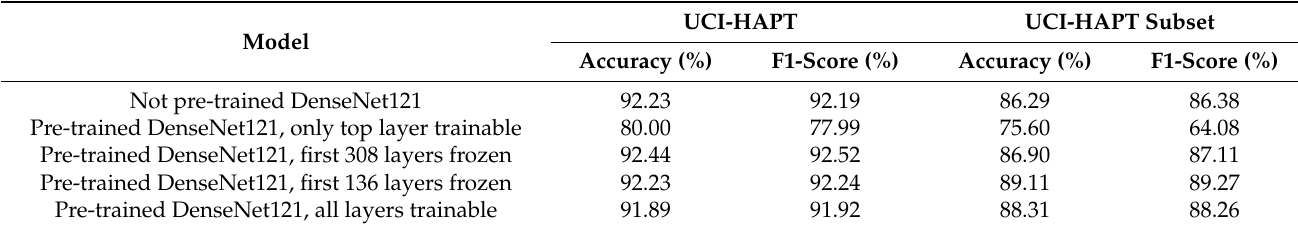
Table 3. Performance comparison of pre-trained and non-pre-trained models during fine-tuning.